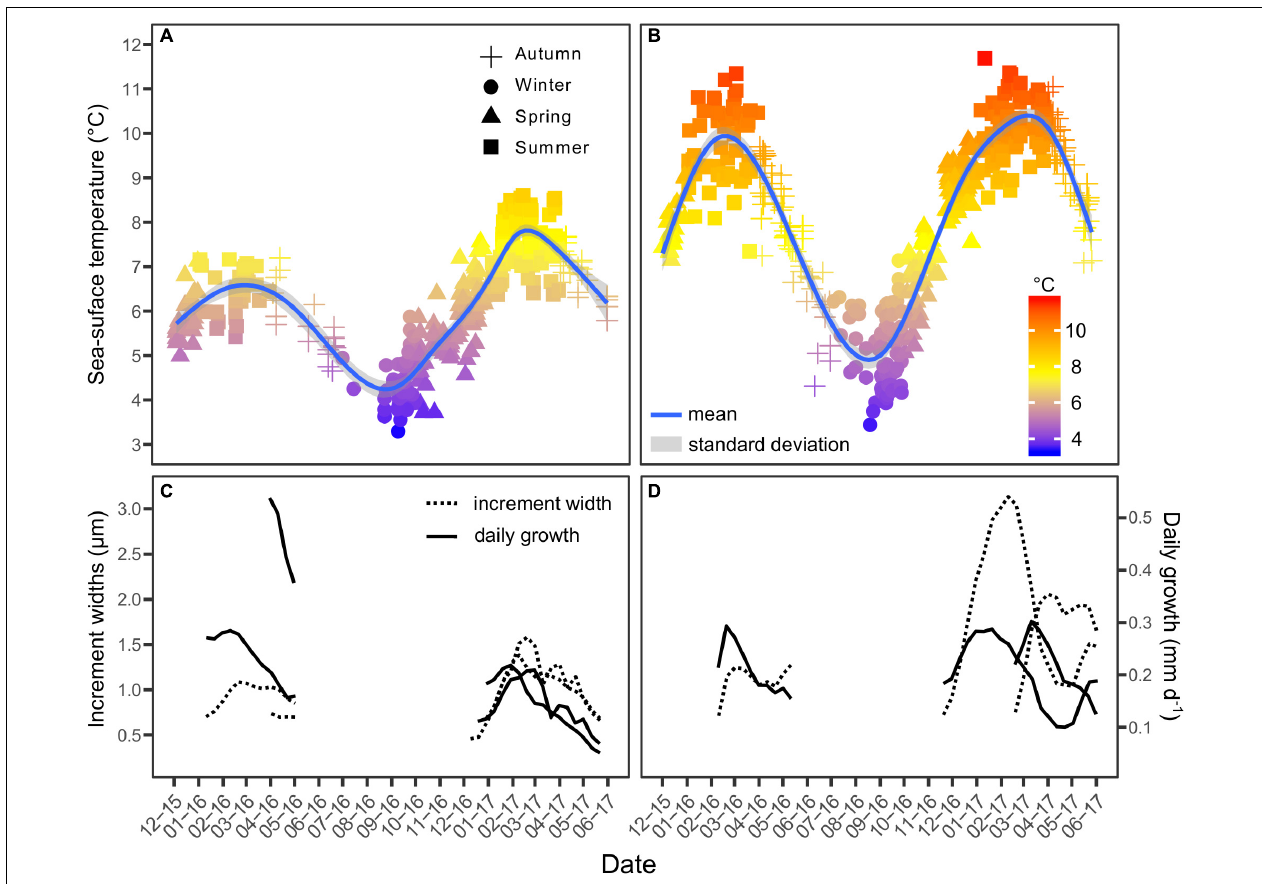
FIGURE 6 | Sea-surface temperature ( ◦ C) time series in the Marine Protected Area Namuncurá-Burdwood Bank (MPAN-BB) (A) and in Tierra del Fuego (TDF) (B) . Sites from which data was obtained are shown in the reference maps. Shapes indicate the season of the record. Mean trajectories of increment widths ( µ m; dotted lines) and daily growths (mm d − 1 ; solid lines) for each habitat, survey and season of hatching are displayed (C–D)